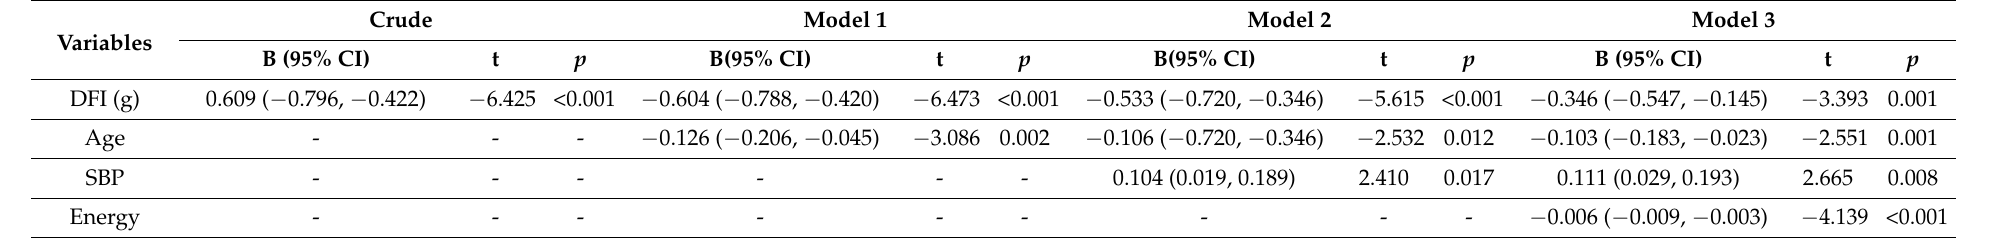
Table 3. Regression analysis summary for the score of depression.